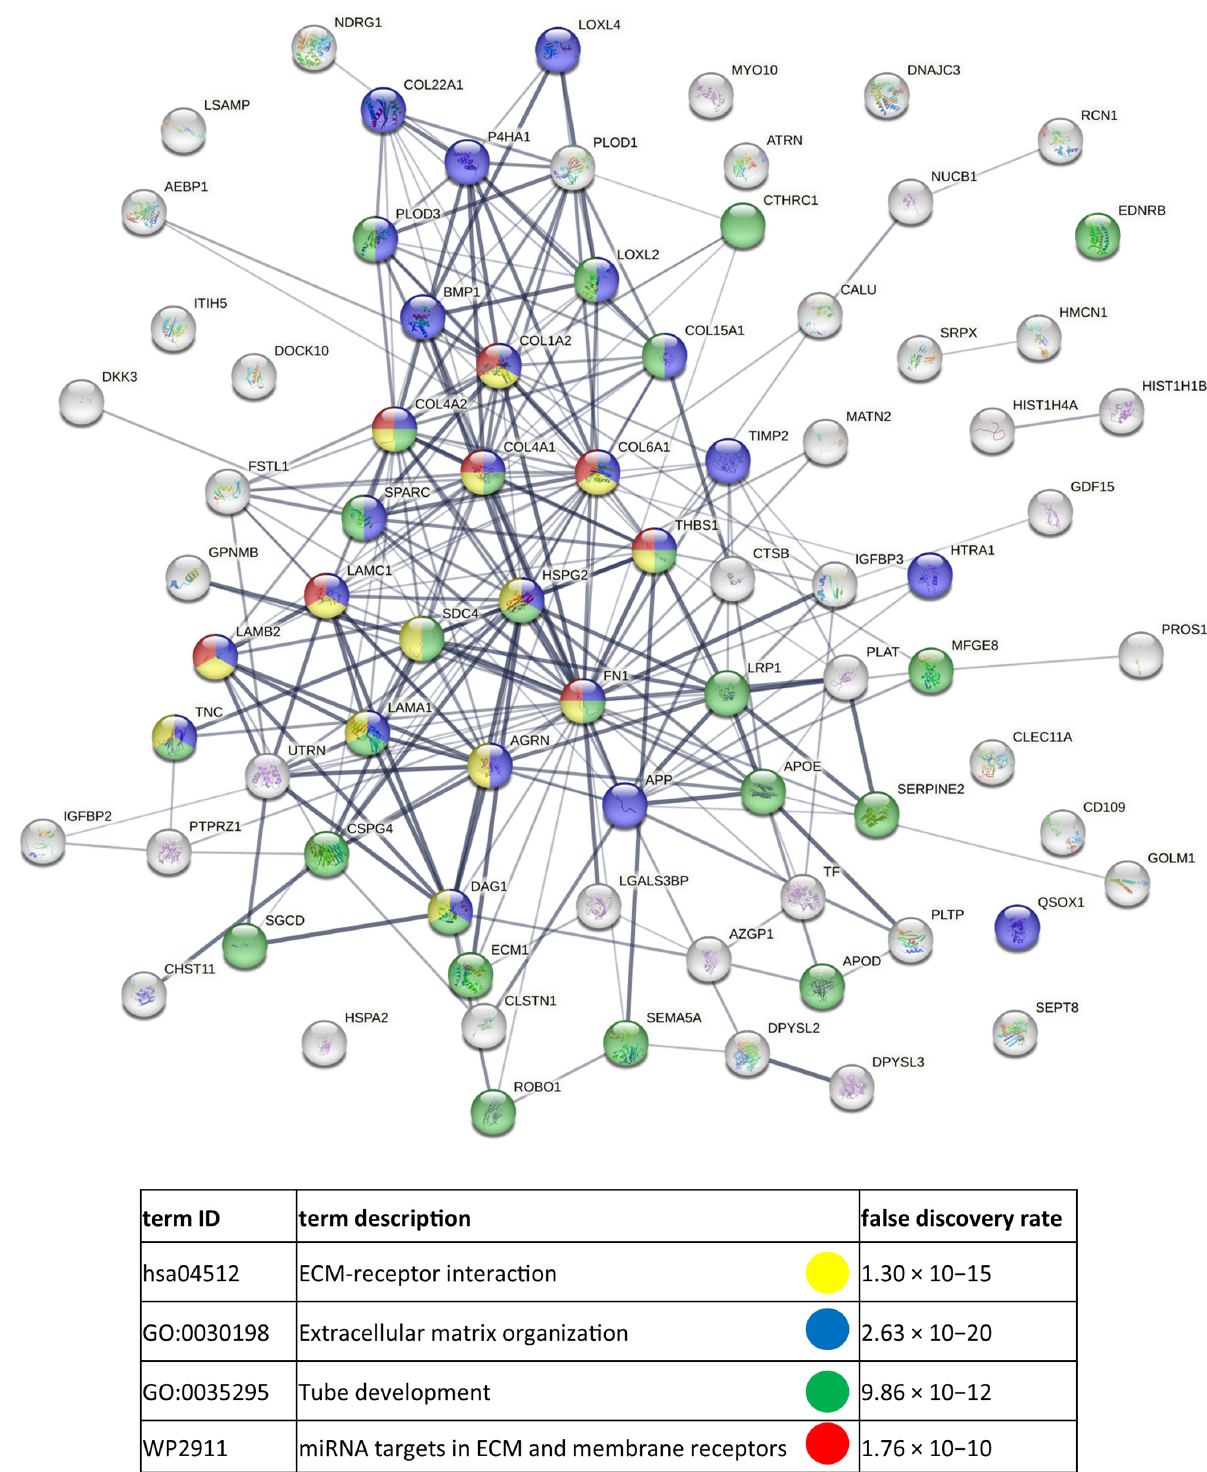
Figure A13. Diagram of functional protein association networks prepared with the use of STRING v. 11.0 software for proteins upregulated in WM266-4-derived exosomes vs. WM115-derived exosomes. The selected, strongly represented pathways are presented as an interactome. Proteins with fold change > 1.2 were considered upregulated in WM266-4 cells ( p < 0.05). A complete analysis is presented in Supplementary Data